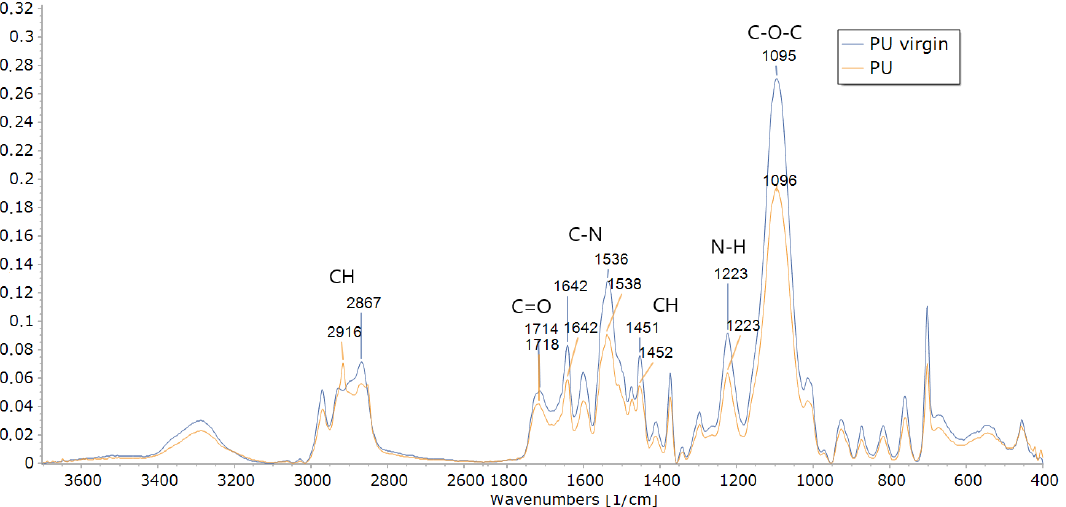
Figure 1 . The Fourier Transform Infrared spectroscopy (FTIR) analysis of PU foam (PU) and original PU foam (PU-virgin) at the end of the experiment (17 days) .